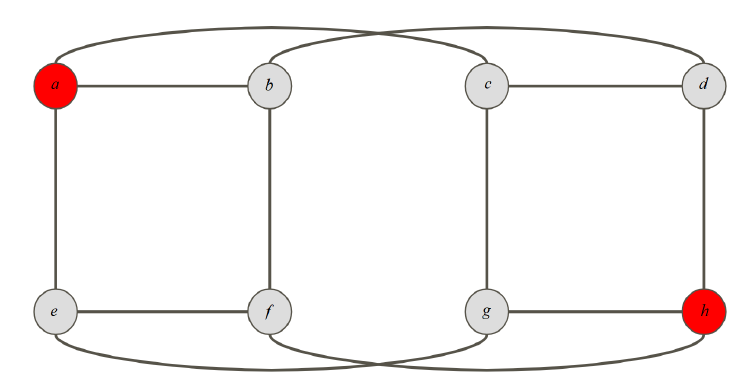
Figure 1. Minimum dominating set for Q 3